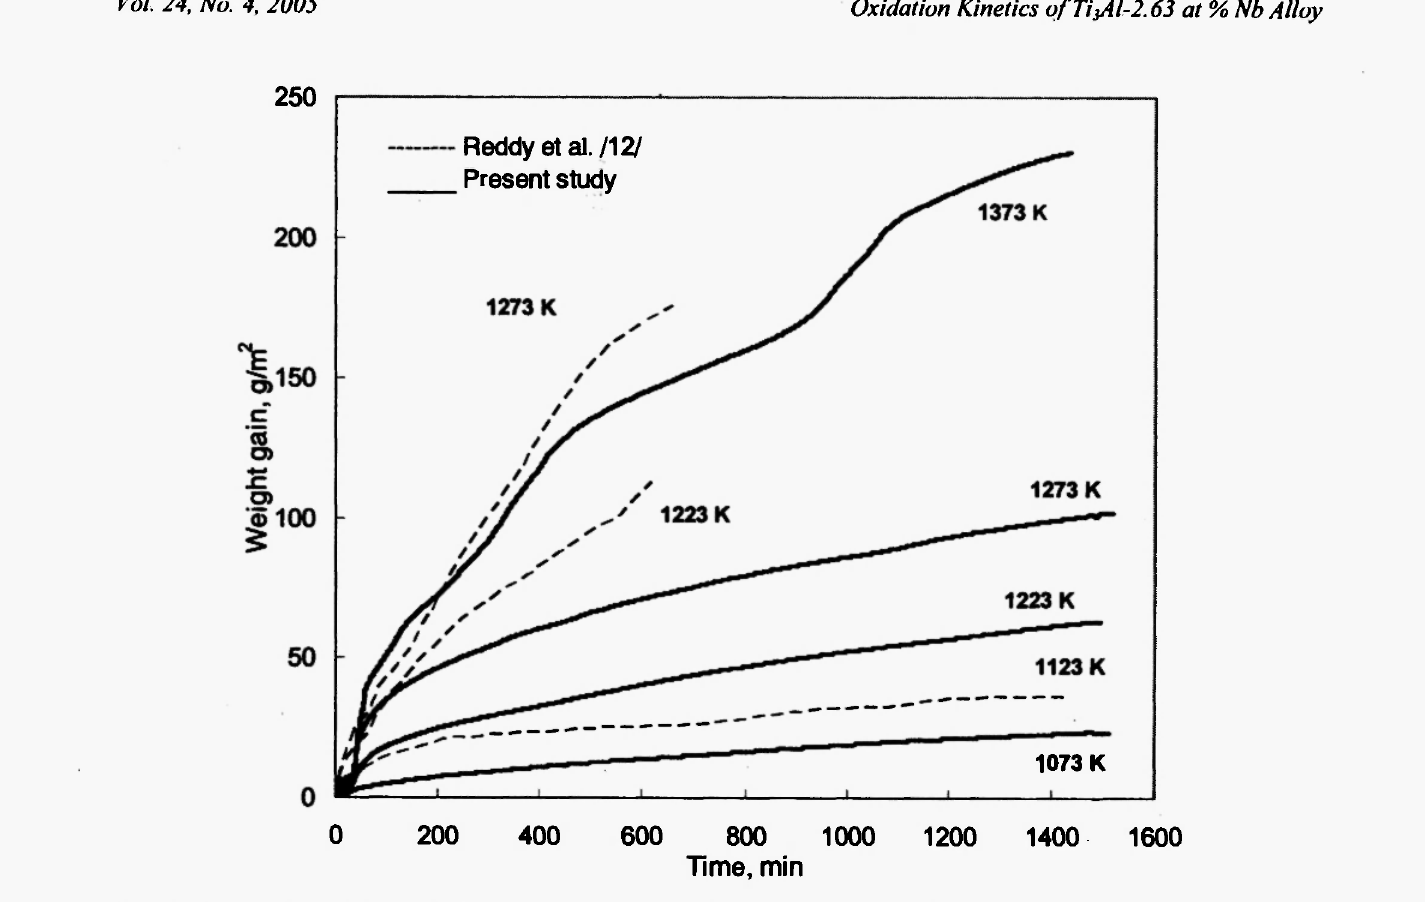
Fig. 2: Comparison of the oxidation data of Ti 3 Al-2.63 at % Nb alloy and that of a previous study /12/ in pure oxygen at different